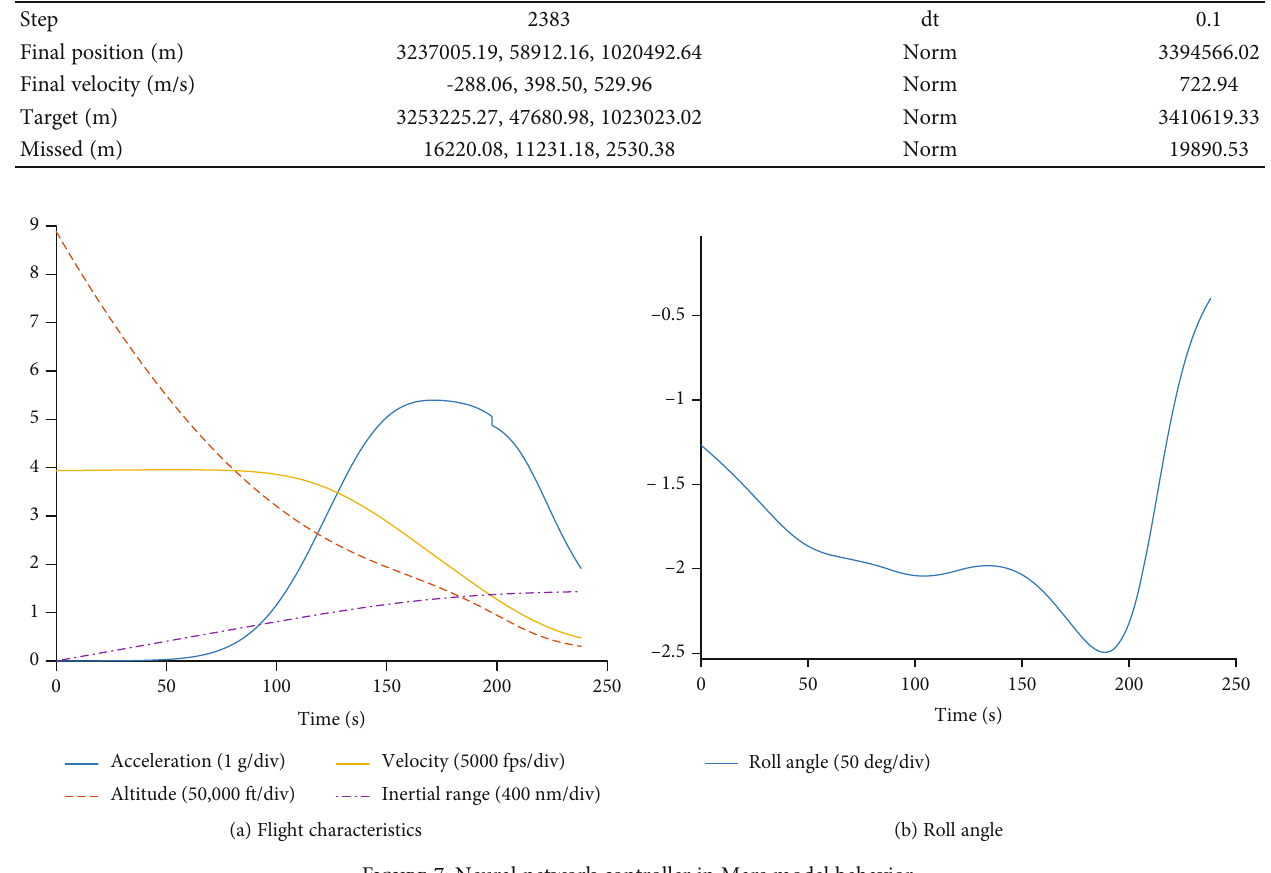
Figure 7: Neural network controller in Mars model behavior. Table 10: Nonlinear integration with 10-layer NN in the Mars